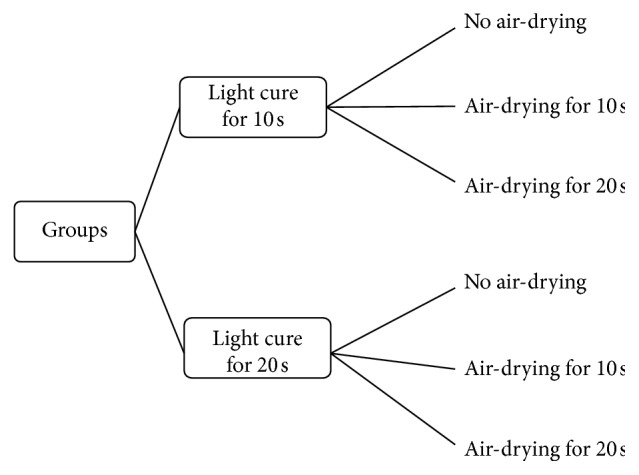
Experimental design.